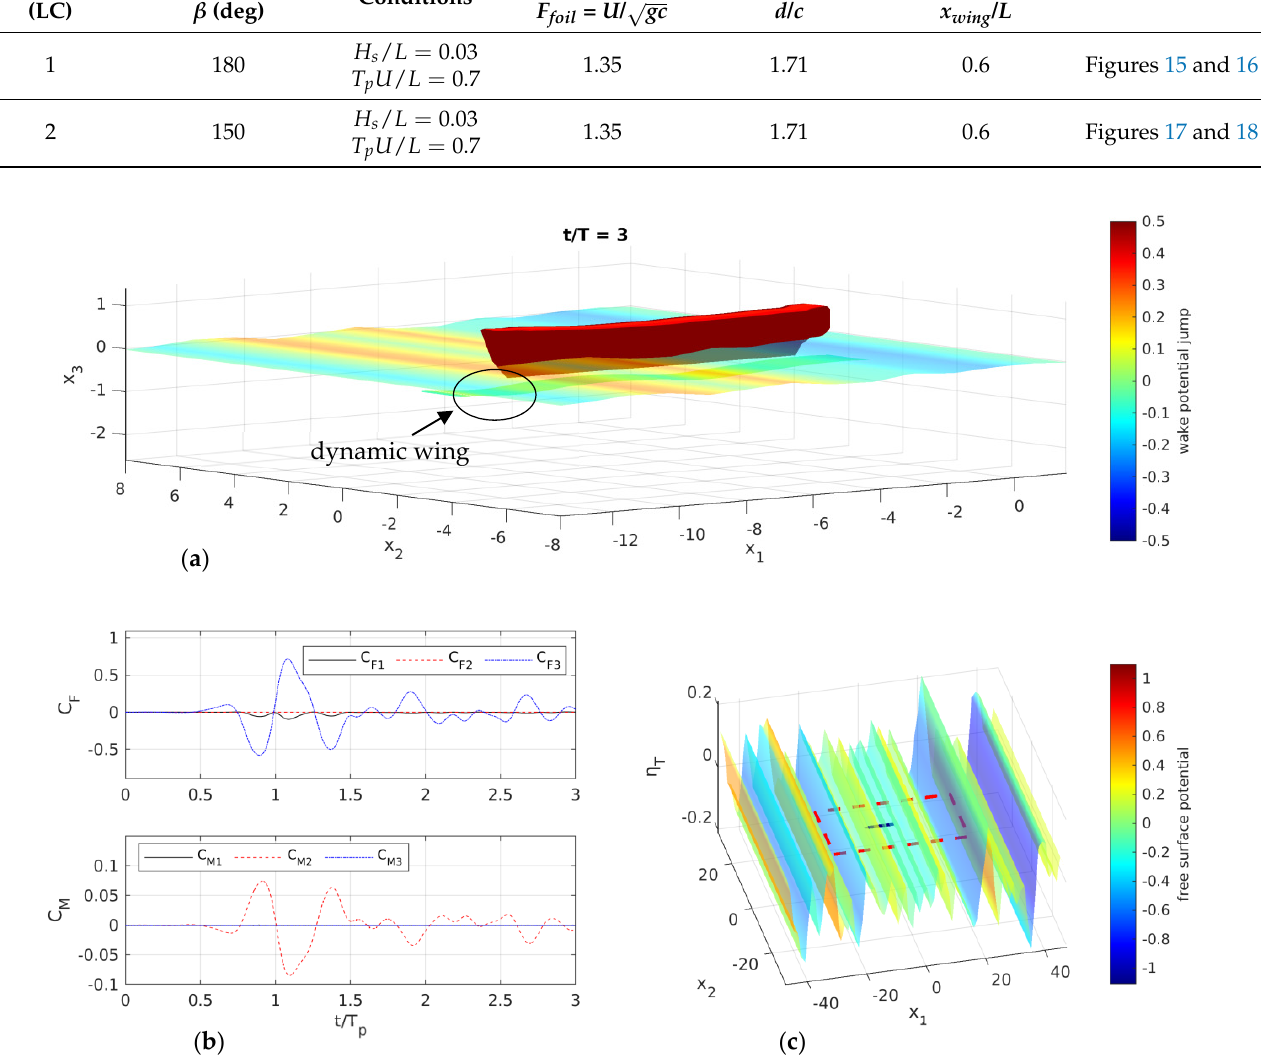
Figure 15. BEM simulation of the ferry and the dynamic wing in head waves ( β = 180 ◦ ): ( a ) total free-surface elevation and potential (denoted with colors), interaction with the foil wake located on the ship bow; ( b ) time evolution of forces and moments acting on the foil; ( c ) total free-surface elevation and potential (denoted with colors) all over the computational domain.